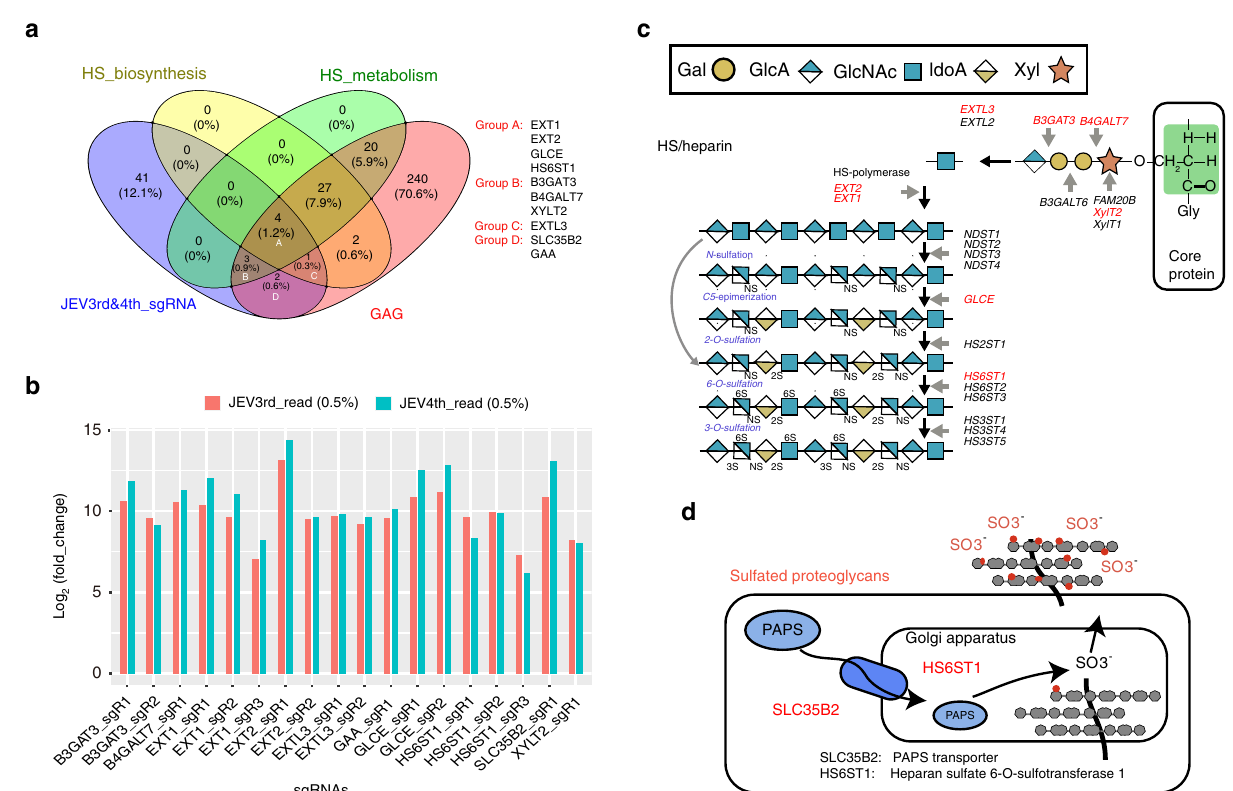
Fig. 3 Signi fi cant enrichment of speci fi c sgRNAs targeting 10 genes involved in HSPGs synthesis and metabolic pathways. a Venn diagram showing the overlapping enrichment of speci fi c sgRNA targeted genes identi fi ed in the JEV screen of the cell knockout collection, HSPGs biosynthesis and metabolism, and GAG metabolism pathways. b Enrichment of speci fi c sgRNAs targeting 10 genes involved in HSPGs synthesis and metabolic pathways. Only the top 0.5% of sgRNA was counted. c Schematic diagram, adapted from Tanaka et al. 28 , showing the various classes of chemical components comprising HSPGs with known enzymes for their biosynthesis. Red indicates targeted genes identi fi ed in this study. d Schematic diagram, adapted from Blondel et al. 34 , showing the known components and localization information for the sulfurylation modi fi cations known to occur for some HSPGs. Red indicates targeted genes identi fi ed in this study. JEV, Japanese encephalitis virus; HS, Heparan sulfate; GAG, Glycosaminoglycan; HSPGs, heparan sulfate proteoglycans; PAPS, 3 ’ -Phosphoadenosine-5 ’ -phosphosulfate; JEV3rd, the third challenge round of JEV screening; JEV4th, the fourth challenge round of JEV screening. Source data are provided as a Supplementary Data fi